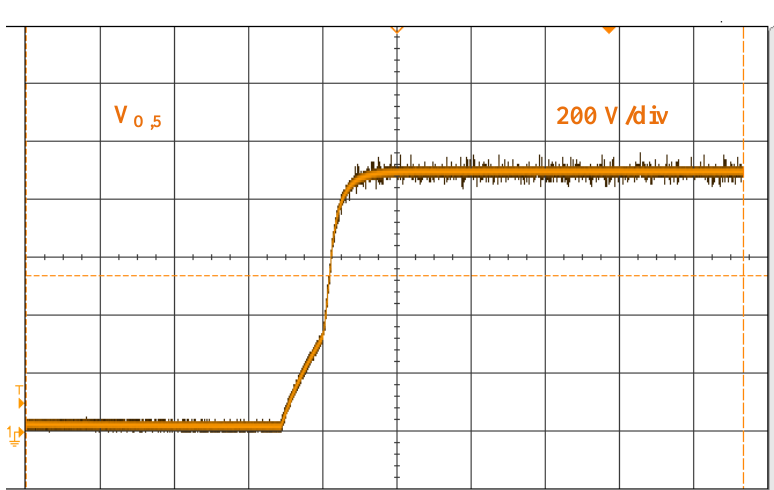
Figure 15. Output voltage V o,4 of stage 4.